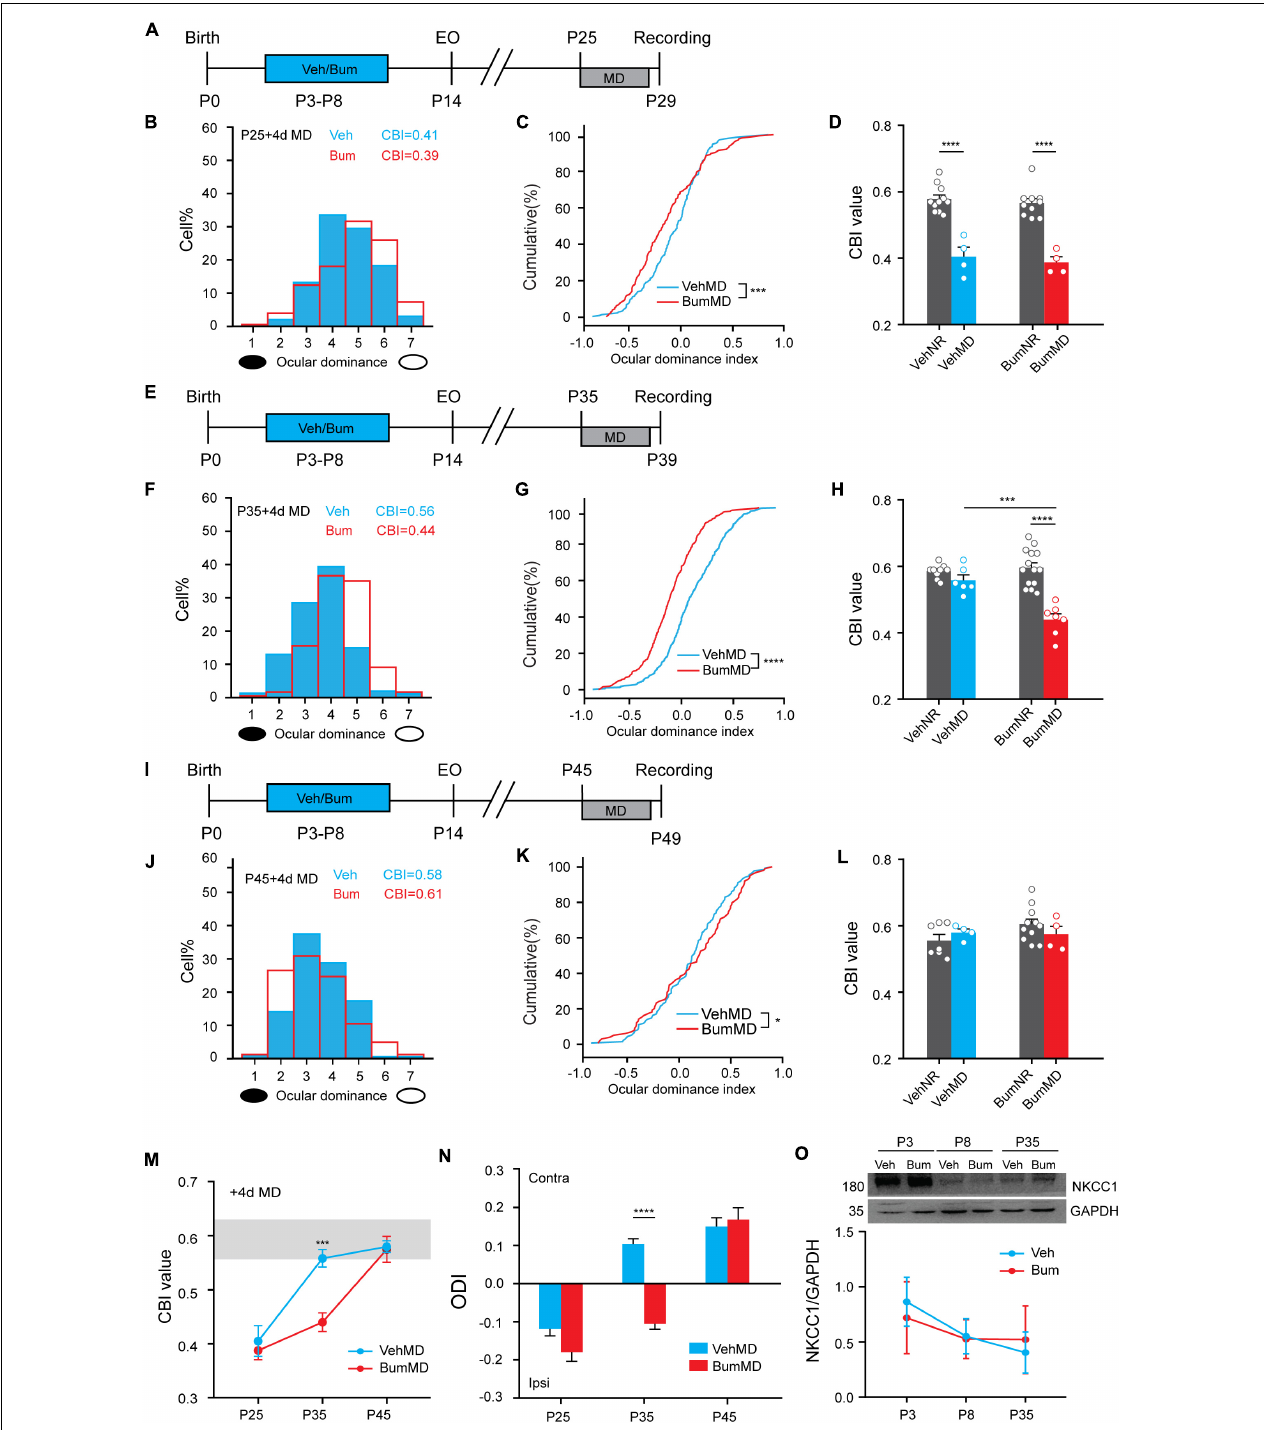
FIGURE 1 | Early bumetanide interference prolongs critical period plasticity in mouse binocular zone of visual cortex (V1b). (A) Contralateral eye bias assessed by single-unit electrophysiology in mouse primary visual cortex after monocular deprivation for 4 days (4d MD) at P25. (B) Ocular dominance (OD) distribution for vehicle (Veh, blue) and bumetanide (Bum, red) were similar. The OD distribution is still significantly shifted toward the non-deprivation eye (open circle) for Veh and Bum mice. (C) OD cumulative distribution for Veh and Bum group. OD distribution for Bum group (177 cells, four mice) statistically different from Veh mice [295 cells, four mice, p < 0.0004, Kolmogorov-Smirnov (K-S) test]. (D) Contralateral bias index (CBI) value for VehMD, VehNR, BumMD, and BumNR animals. The CBI of VehNR mice was significantly different from that of VehMD animals (VehNR: 166 cells, 11 mice, p < 0.0001); The CBI of BumNR mice was significantly different from that of